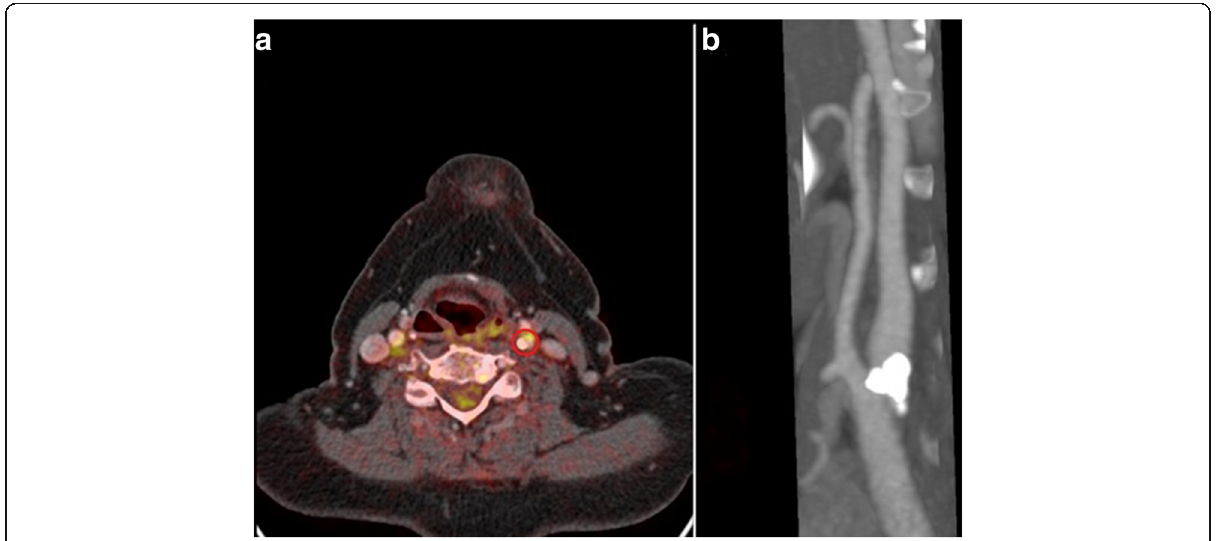
Fig. 3 a The point of maximum stenosis was used as midpoint of the segment analysed ( red circle ). b The stenosis identified on MIP images within the left internal carotid